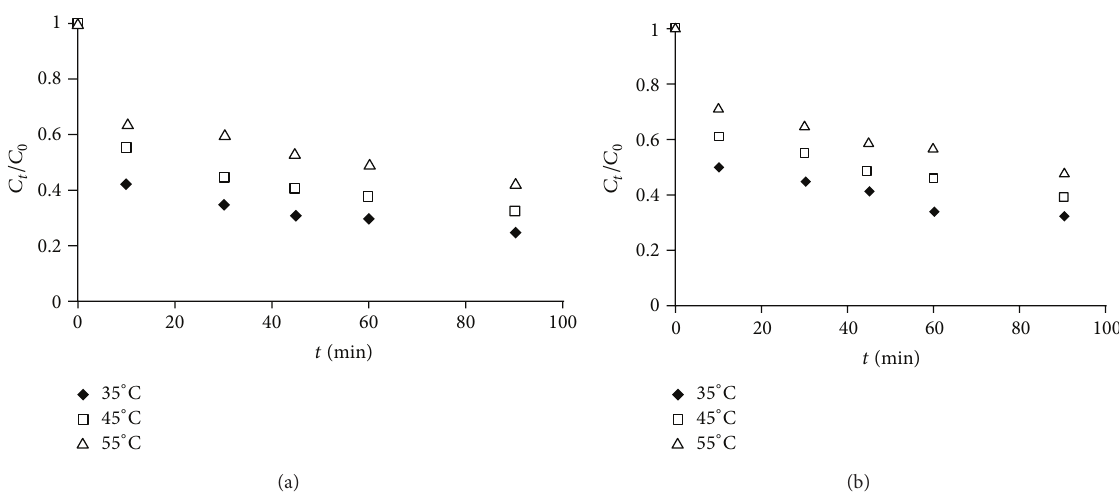
Figure 5: Effect of Temperature on OM retention using: (a) RBC and (b) RGC; (Particle size: 63 𝜇 m; 𝐶 0 = 491 ppm; 𝑆/𝐿 = 20 g/L).